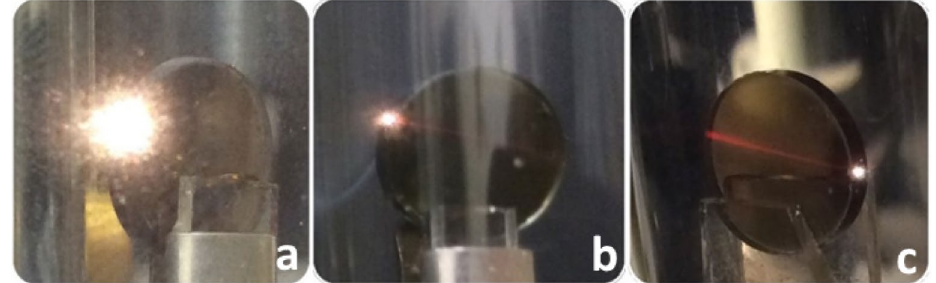
Figure 2. The photos of LIWE observed for Cr:YAG ceramic pellet under different: high ( a ), intermediate ( b ) and low ( c ) excitation power densities using CW 1064 nm laser focused to a spot with the diameter of 175 µm in vacuum ( c